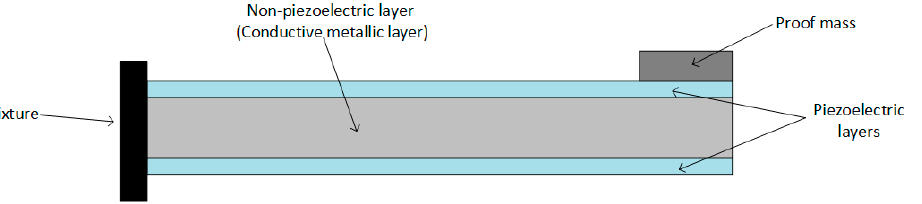
Figure 5. Cantilever beam transducer.